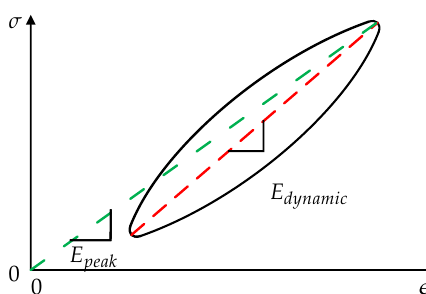
Figure 1. Determination dynamic modulus and peak modulus